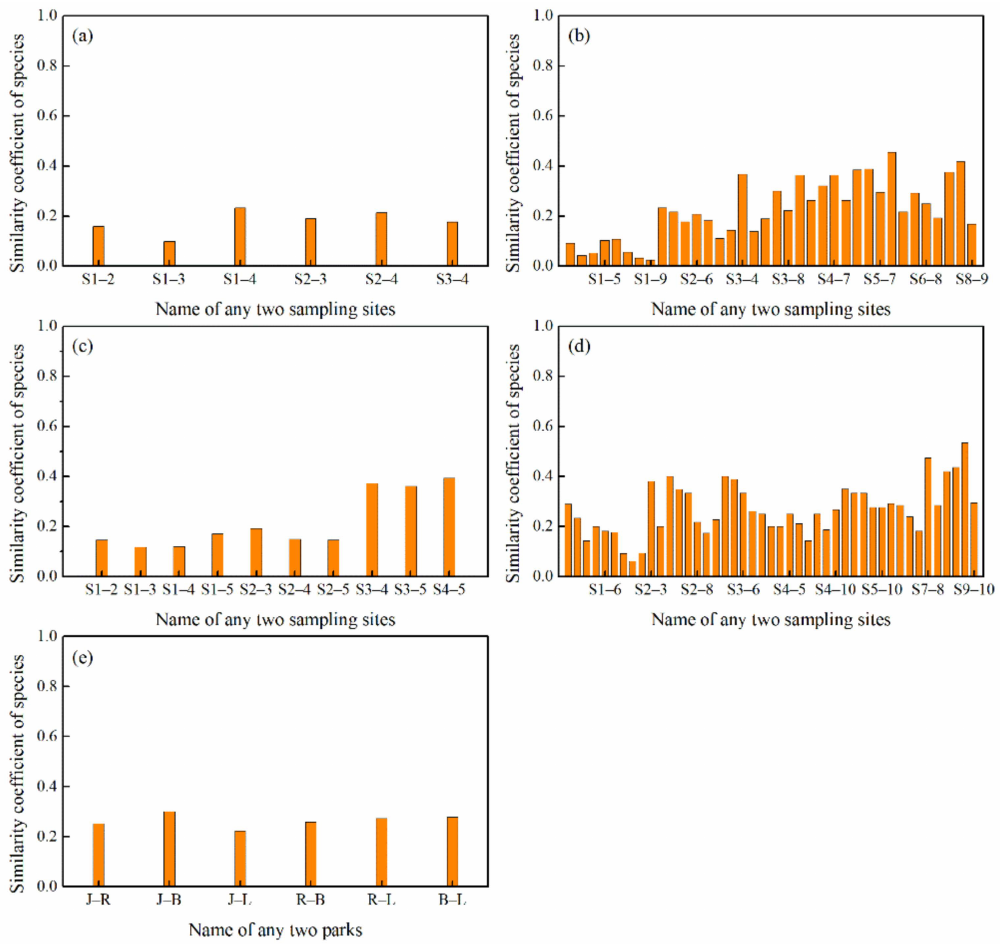
Figure 5. Similarity coefficient of species composition between any two sampling sites within or between parks: ( a ) Jincheng Park; ( b ) Renshoushan Park; ( c ) Baitashan Park ( d ) Lanshan Park and ( e ) similarity coefficient of species among the four